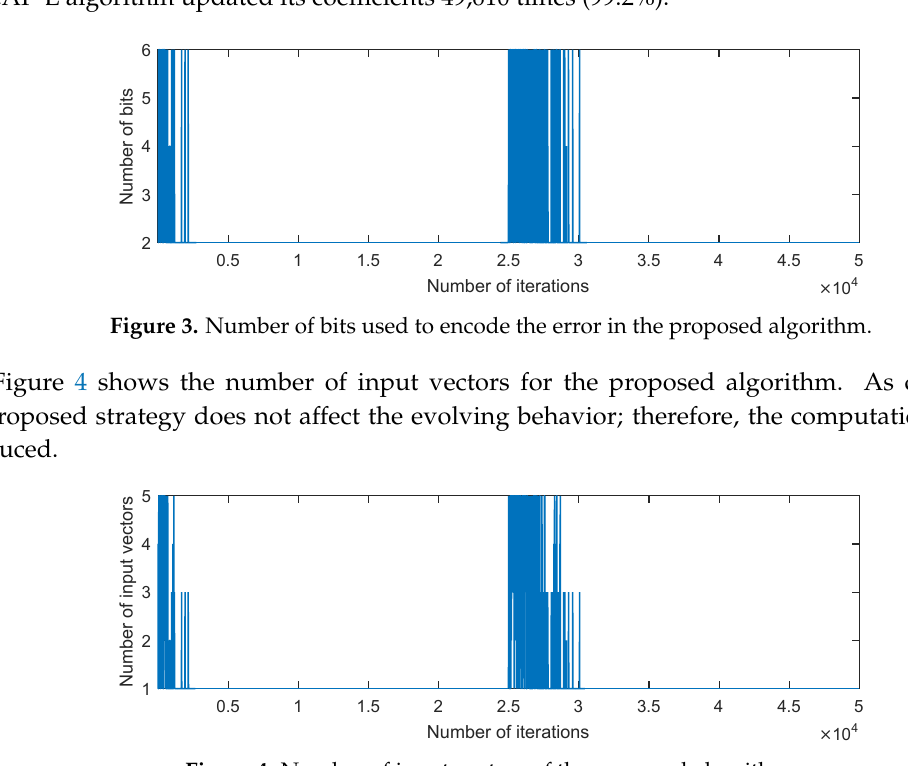
Figure 4. Number of input vectors of the proposed